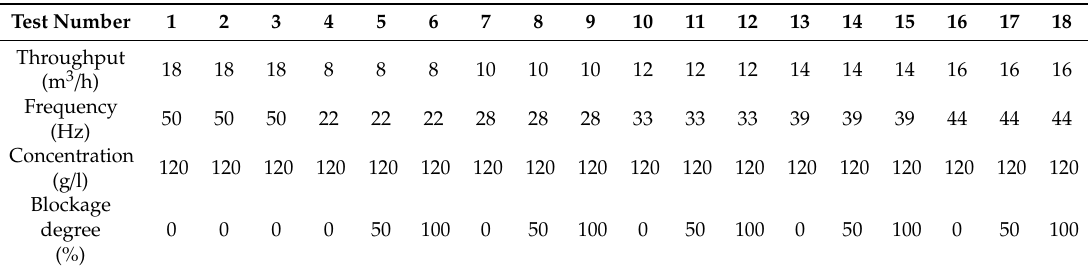
Table 2. Experiment conditions.